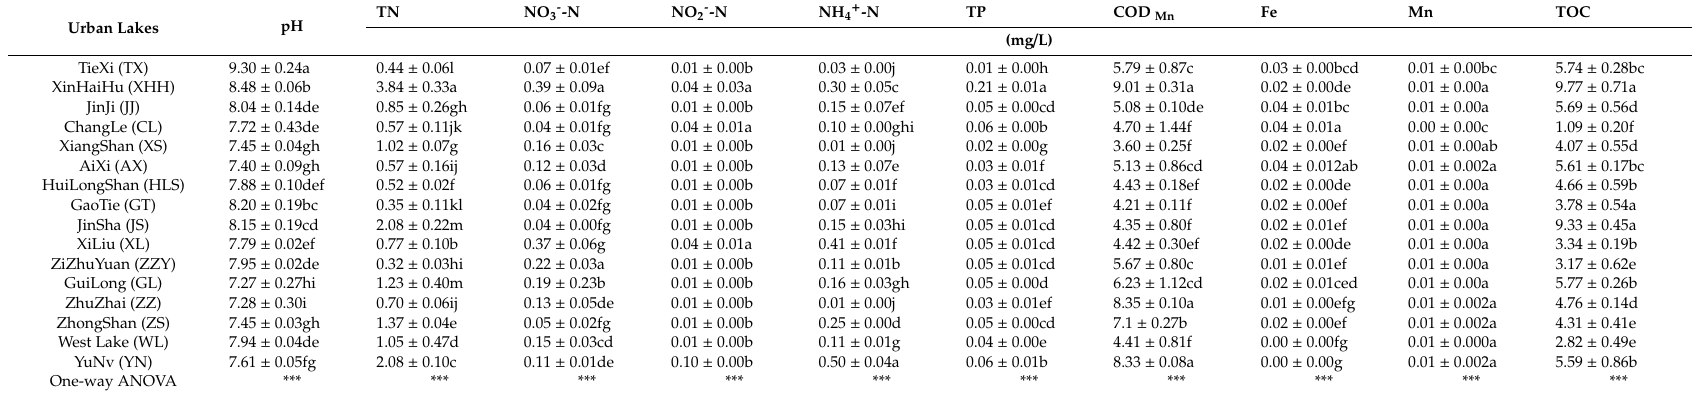
Table 2. Quality parameters associated with 16 di ff erent geographically distributed urban lakes,